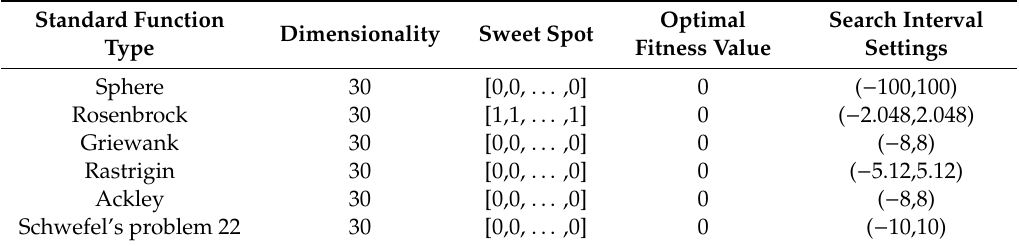
Table 1. Parameter configuration of the test functions.